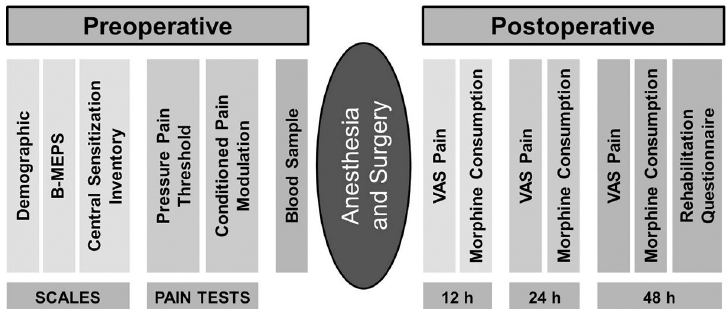
Fig 1. Schematic illustration of the study protocol. The day before scheduled surgery patients completed the Demographic, B-MEPS tool, and Central Sensitization Inventory (CSI). Then, patients underwent a series of experimental pain tests: Pressure pain threshold (PPT), pressure pain tolerance (PPTol) and conditioned pain modulation test (CPM) and blood sample analysis. During postoperative days 1–3 pain-related outcomes were assessed, including postoperative rest pain and movement-evoked pain intensity, and morphine Rehabilitation Questionnaire (QoR-15) was applied on the 3rd day.